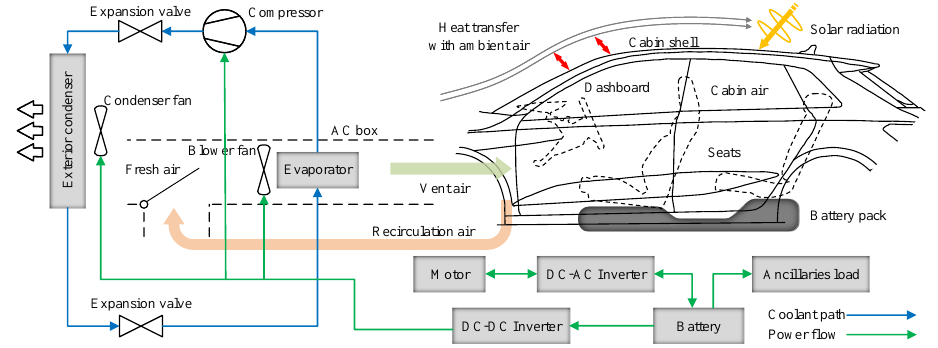
Figure 1. Schematic of the studied EV, including the propulsion system, AC system, and cabin thermal system. The AC system uses a refrigerant cycle with an electrically driven compressor for cooling. In the studied system, the battery pack is passively cooled by ambient air.